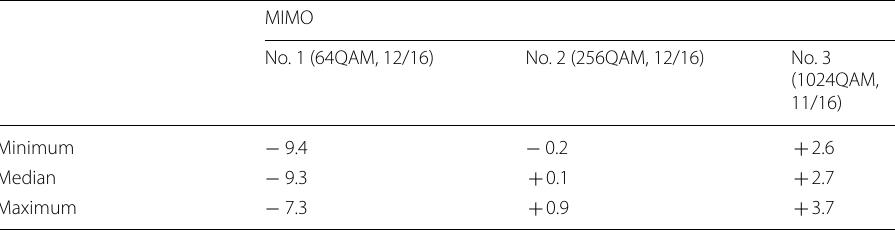
Table 8 Difference in required received power compared with SISO in field experiments (positive value means higher received power required) MIMO No. 1 (64QAM, 12/16) No. 2 (256QAM, 12/16) No. 3 Minimum −